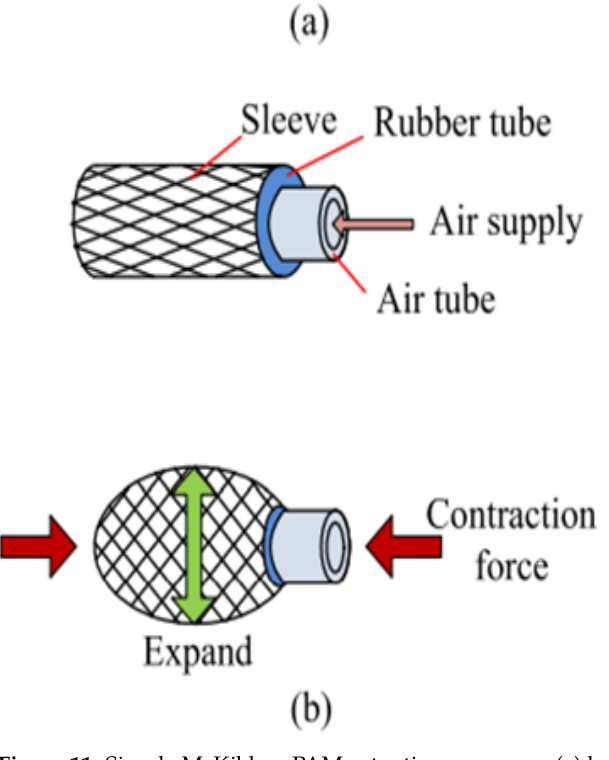
Figure 11. Simple McKibben PAM actuation sequence. ( a ) has the inner sleeve shown at rest with the sleeve and rubber tube holding an inner air tube to feed the air supply into. ( b ) shows the sleeve becoming pressurized and showing an expansion of the air and rubber tube as well as the sleeve expanding in the radial direction (Reprinted with permission from Peng, Y. et al. [106]. Copyright 2019, with permission from